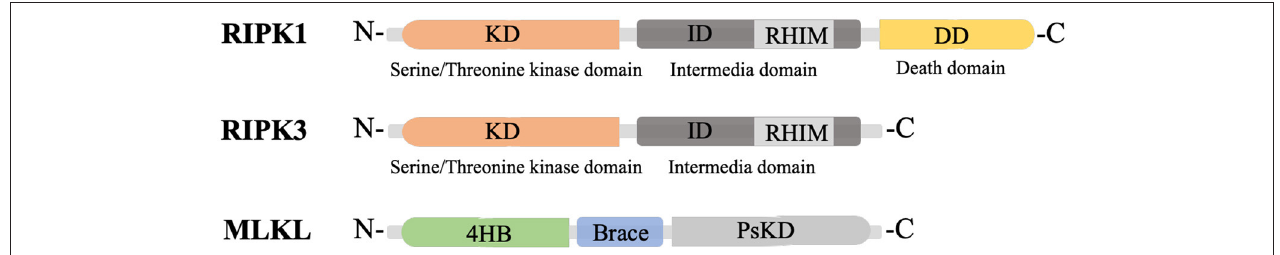
FIGURE 1 | Structure of RIPK1, RIPK3 and MLKL. KD, N-terminal kinase domain; ID, intermediate domain; RHIM, RIP homotypic interaction motif; DD, death domain; 4HB, 4-helix bundle; PsKD, pseudokinase